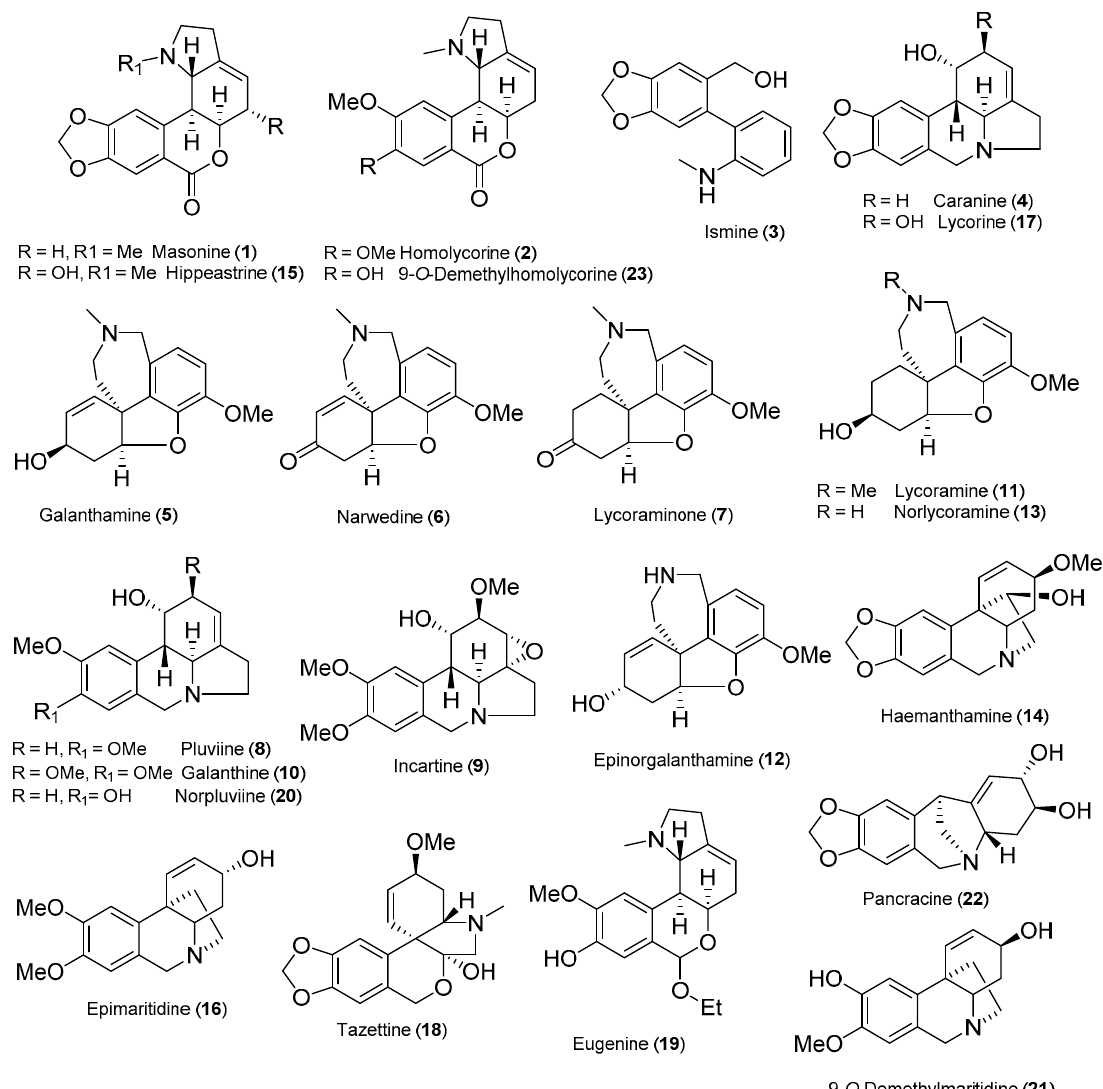
Figure 1. Structures of isolated alkaloids.